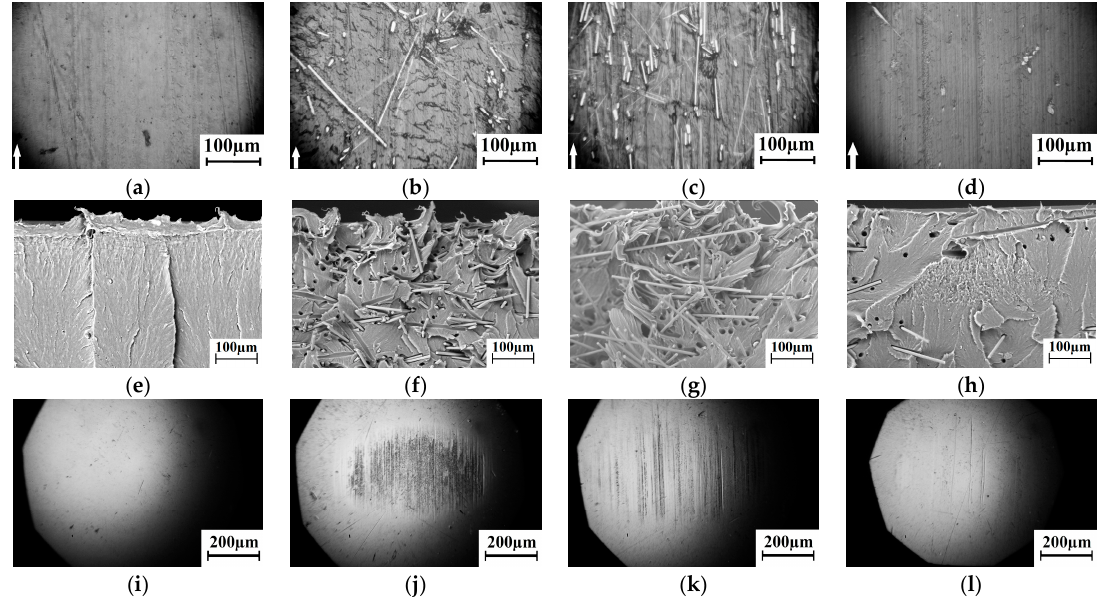
Figure 17. Optical images of the wear track surfaces and ( a – d ), the SEM-micrographs of the permolecular structure of the wear subsurface layer ( e – h ), and the counterpart surfaces ( i – l ) after tests at P = 140 N and V =0.5 m/s: ( i ) UHMWPE + 0.5% CNF; ( j ) UHMWPE + 10% CF; ( k ) UHMWPE + 10% LCF; ( l ) UHMWPE + 10% HDPE-g-SMA + 2% LCF + 0.5% CNF.